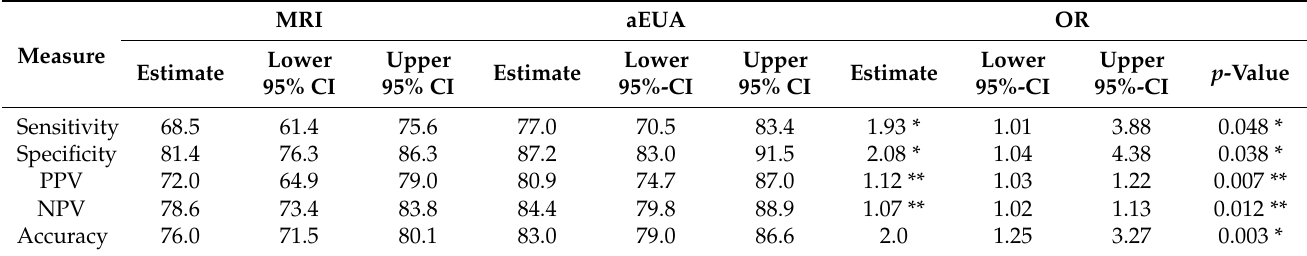
Table 2. Diagnostic performance metrics of MRI and aEUA for pathologically confirmed parametrial infiltration.